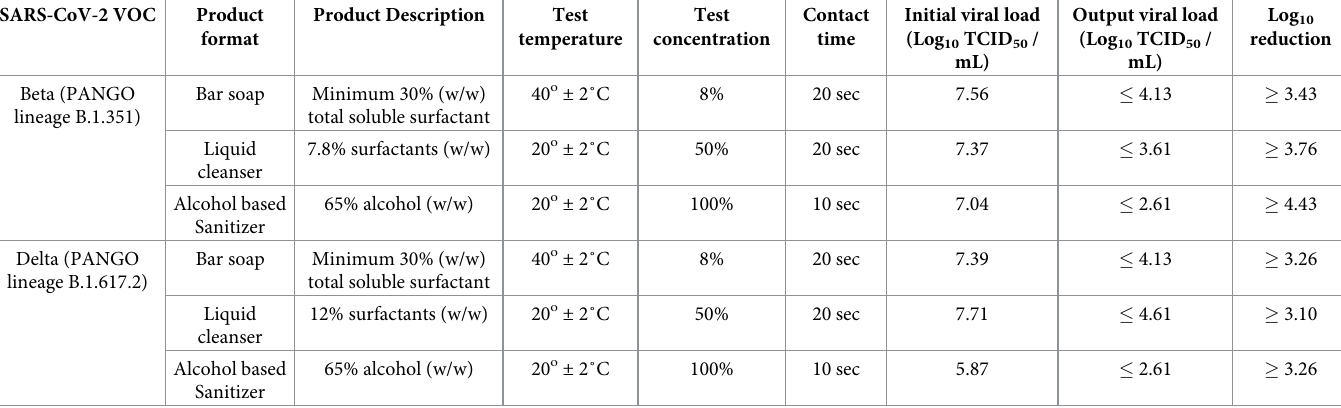
Table 1. Virucidal efficacy of a range of commercially available proprietary personal care formulations tested against selected SARS-CoV-2 variants of concern (VOC) at user relevant dilutions and contact duration. TCID 50 , 50% tissue culture infective dose. SARS-CoV-2